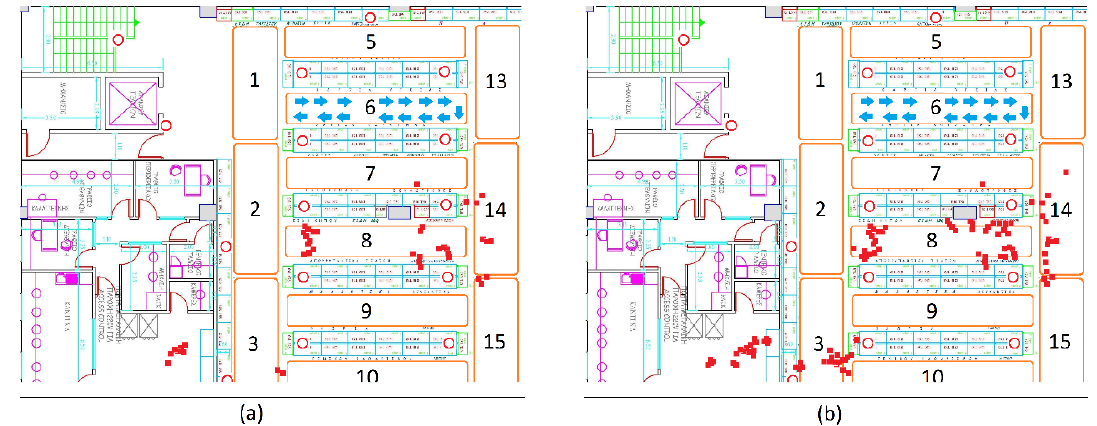
Figure 6. Tri- and multi-lateration performance in the retail store with ( a ) 3 and ( b ) 6 beacons.